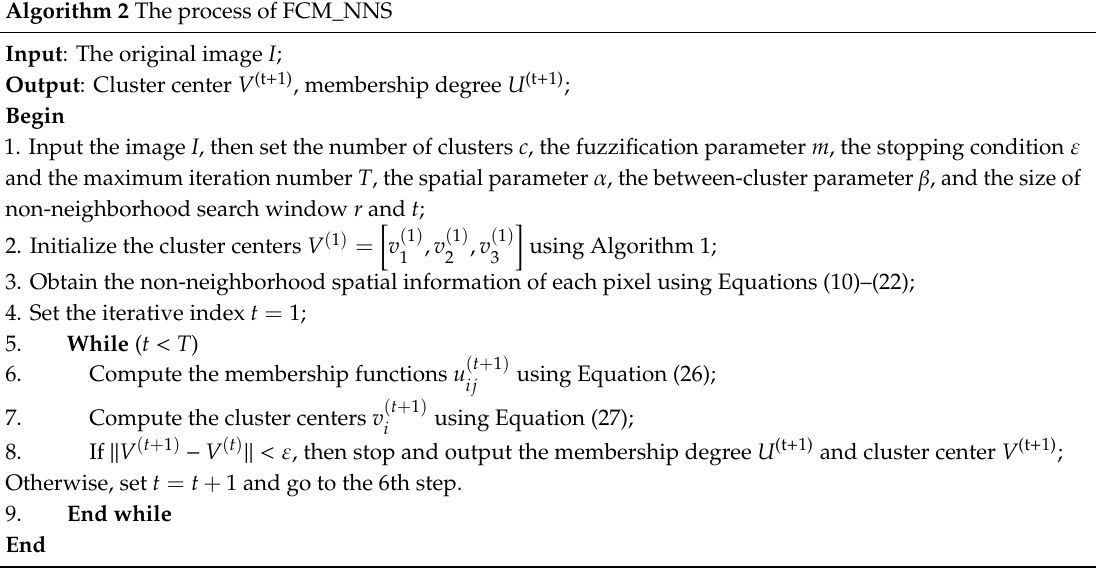
Algorithm 2 The process of